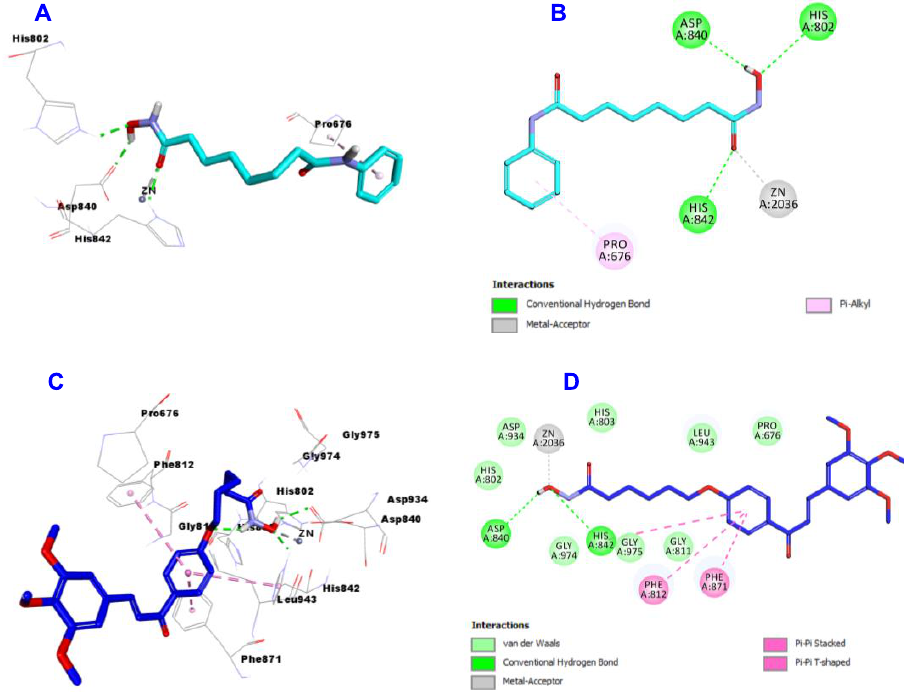
Figure 9. Docking and binding mode of SAHA (cyan) and 4b (blue) into the active site of HDAC 4 (PDB entry: 4CBT); ( A ) 3D structure of SAHA , ( B ) 2D structure of SAHA , ( C ) 3D structure of 4b , ( D ) 2D structure of 4b .